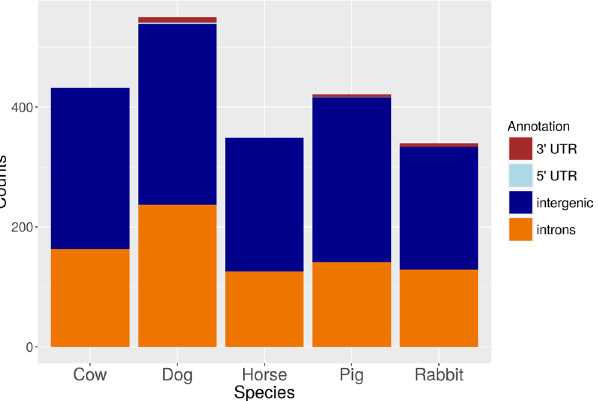
Figure 1. Genomic annotation for all predicted miRNA loci. Colour labelling indicate different genomic features (3 ′ UTR, 5 ′ UTR, intergenic regions,